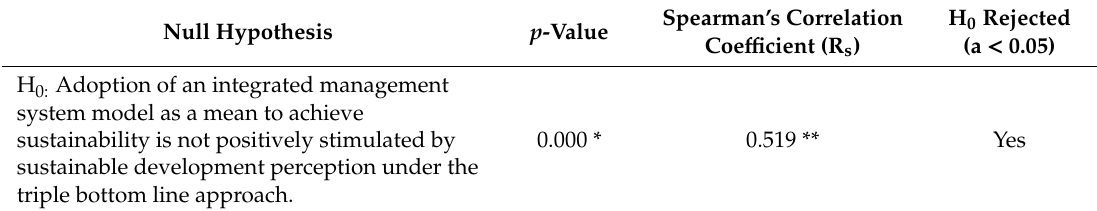
Table 4. Hypothesis 3 Testing: Spearman’s correlation